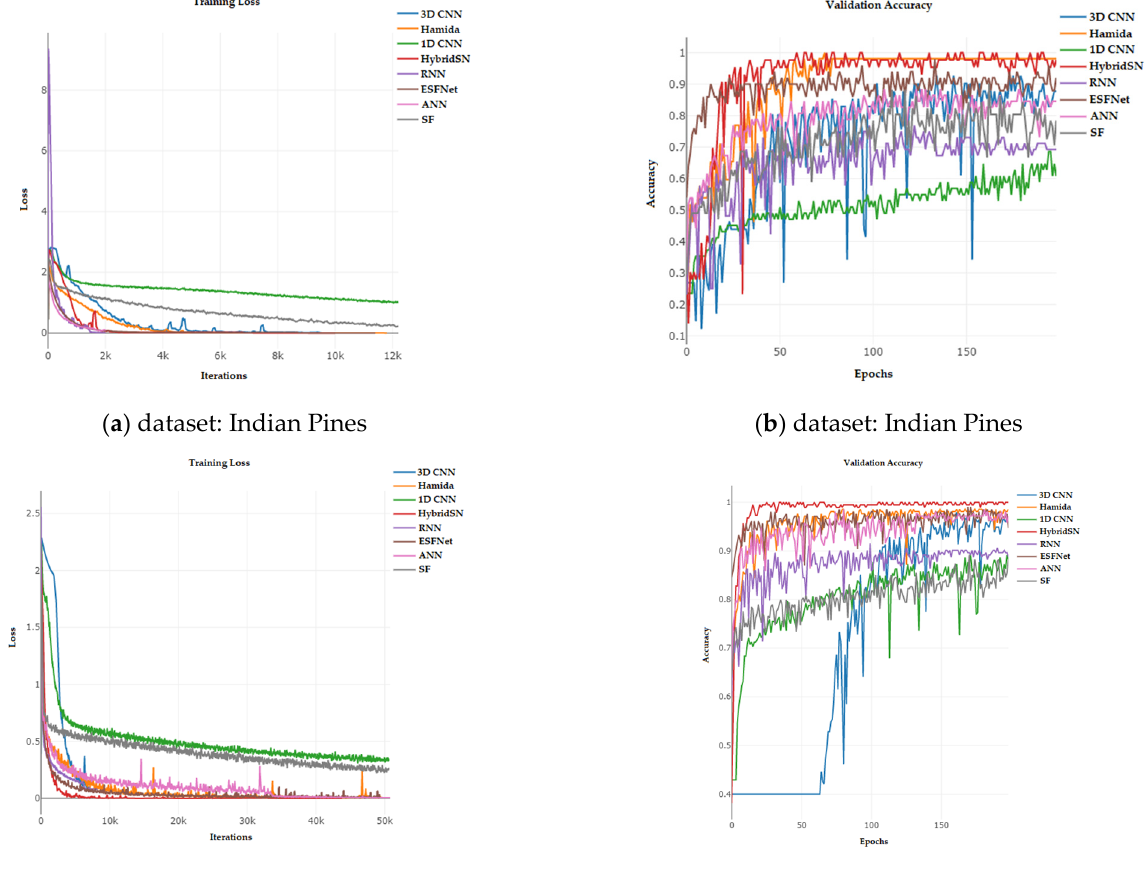
Figure 13. Training loss and validation accuracy of eight models on two datasets. ( a , c ) represents the variation curve of the loss of different models on the two datasets; ( b , d ) represents the variation curve of the validation accuracy of different models on the two datasets.